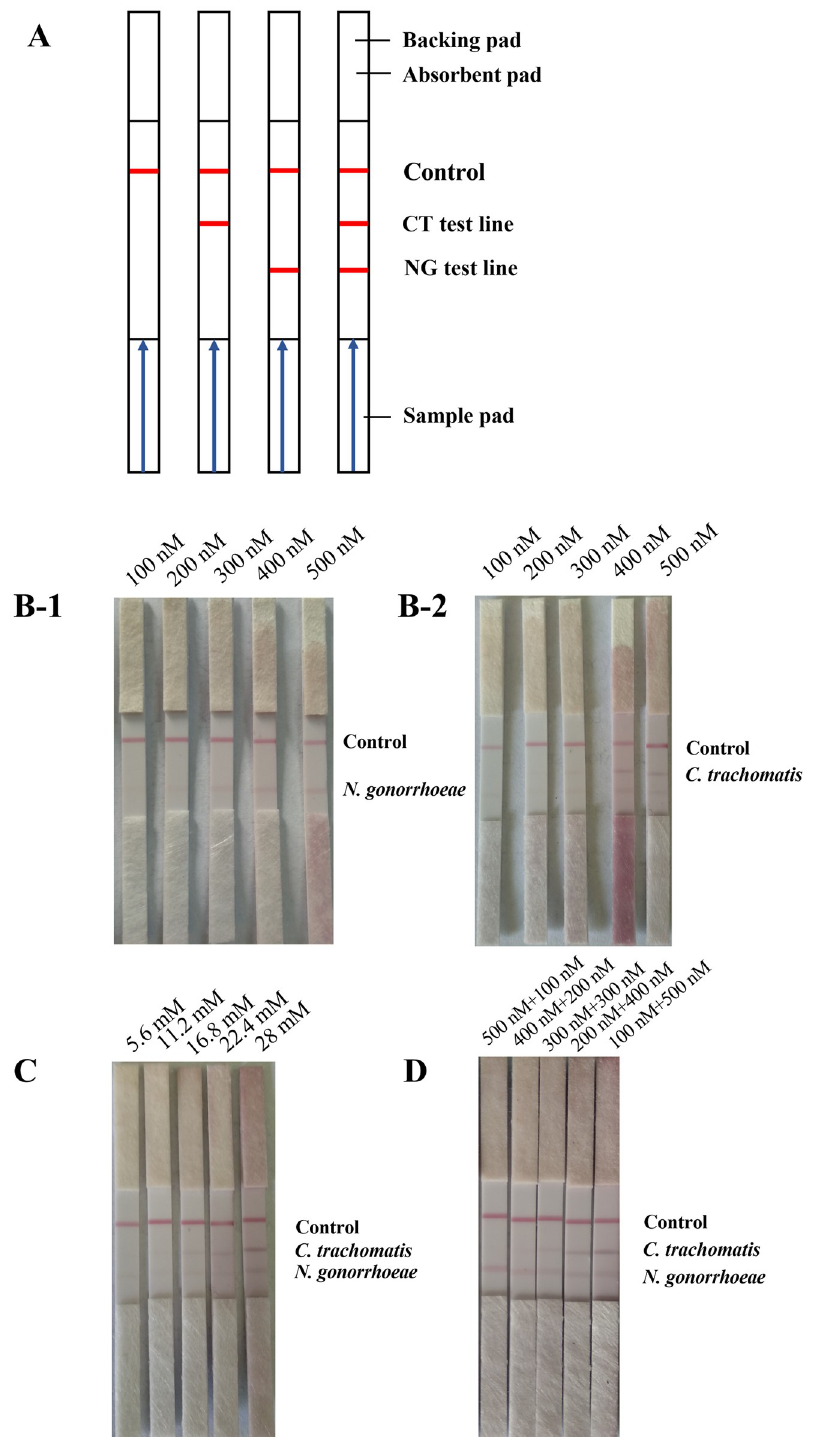
Fig 3. Construction and optimization of LFD detection system. A: Schematic diagram of the LFD system with blue arrows indicating the direction of liquid flow and short red lines marking the positions of the detection and quality control lines; B: The influence of difference in RPA primer concentrations on the assay results of the multiplex of LFD-RPA method (38˚C, 10 min, 16.8 nM Mg 2+ ), B-1: NG, B-2: CT; C: Effect of different magnesium ion concentrations on the assay results of the multiplex RPA-LFD method (38˚C, 10 min, CT 400 nM + NG 200 nM); D: Effect of different primer concentration combinations on the assay results of the multiplex RPA-LFD method (38˚C, 10 min, 16.8 nM Mg 2+